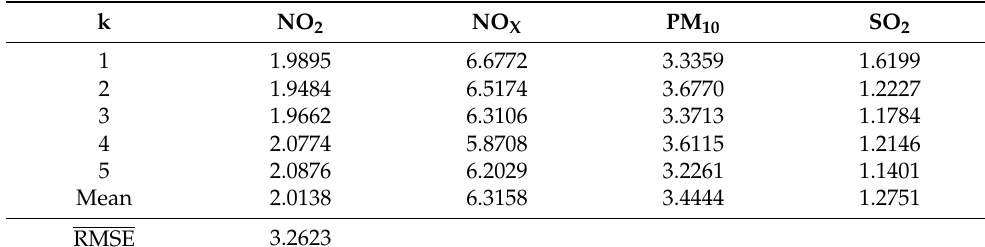
Table 5. RMSE Linear imputation–STATION ST